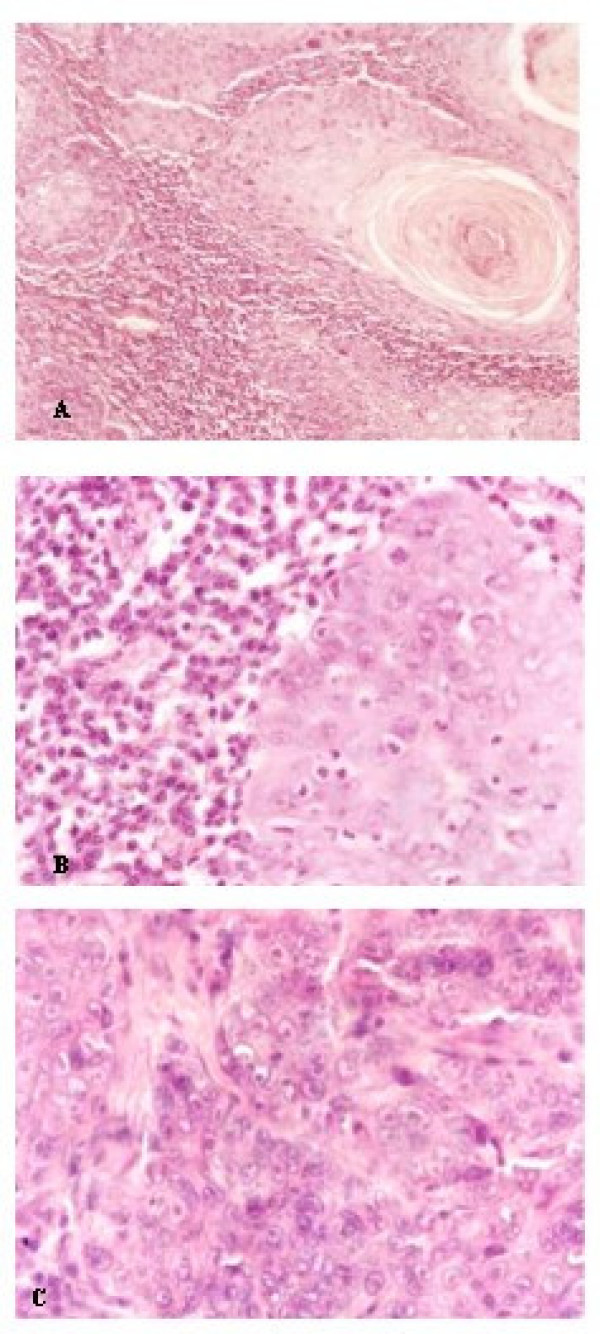
Morphological grading of squamous cells from the buccal mucosa. A: Well-differentiated squamous cell carcinoma of buccal mucosa. N = 10. HE stain. Original magnification 200×. B: Moderately differentiated squamous cell carcinoma of buccal mucosa. N = 10. HE stain. Original magnification 400×. C: Undifferentiated squamous cell carcinoma of buccal mucosa. N = 10. HE stain. Original magnification 400×.